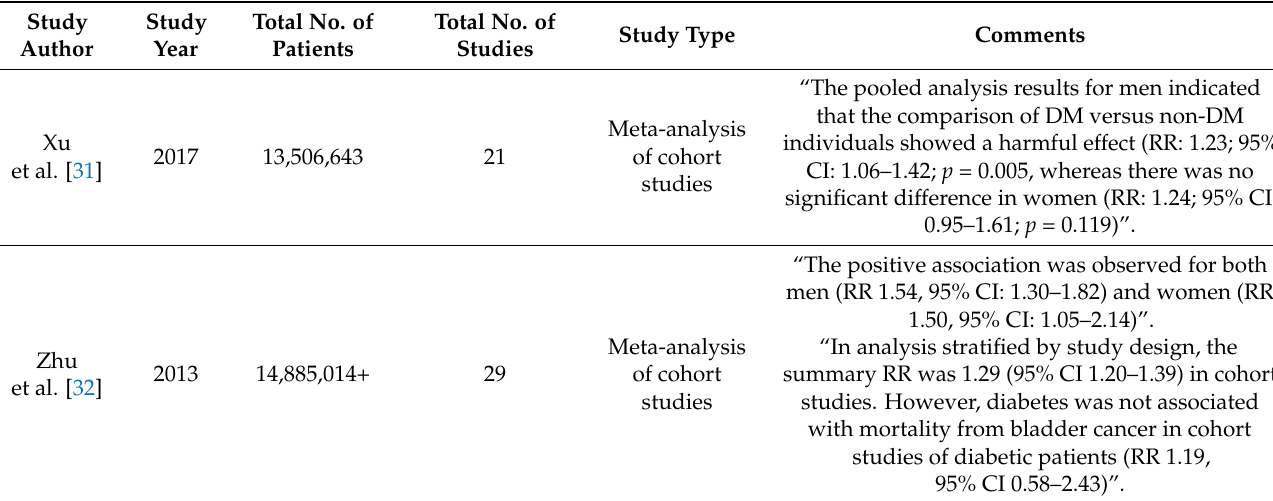
Table 4. Diabetes mellitus and the prognosis of bladder